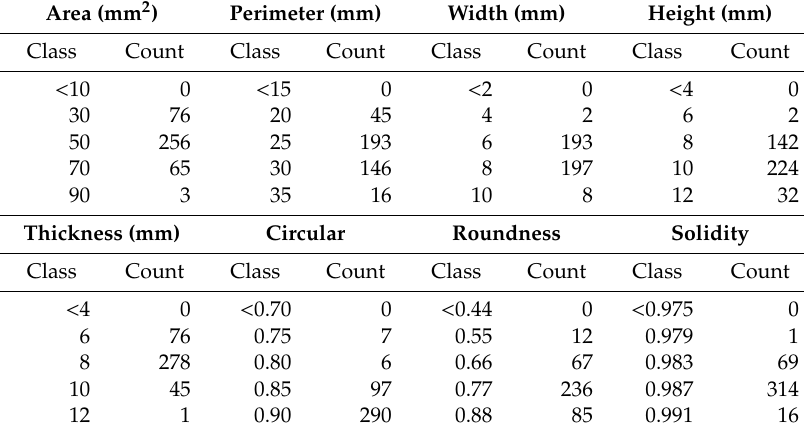
Table 2. Soybean 400 lines morphological range of measurements.